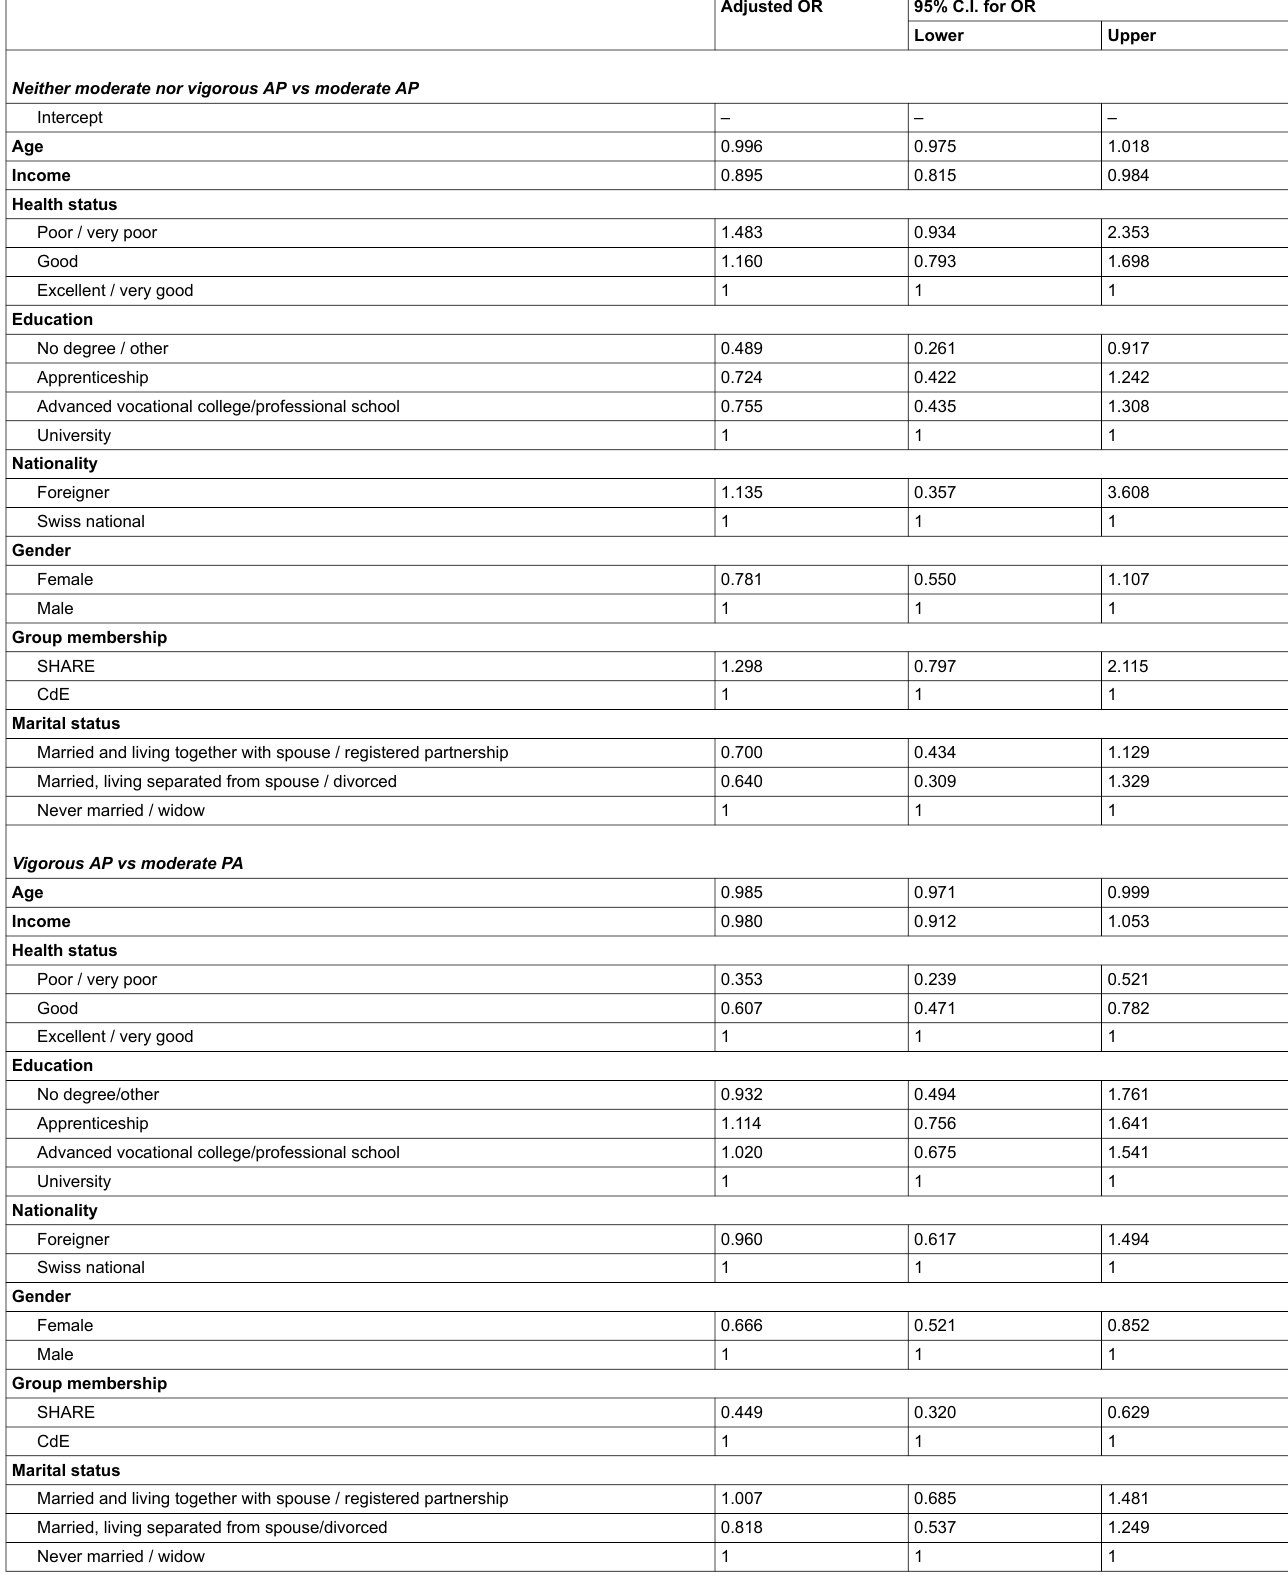
Table 5: Multinomial logistic parameter estimates with group membership (neither moderate nor vigorous AP vs moderate AP vs vigorous AP) as the dependent